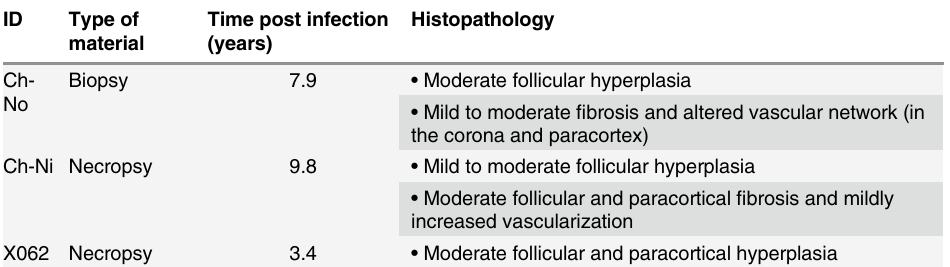
Findings of a veterinary pathologist (IK), upon analysis of H&E, Masson's Trichrome and anti-collagen-I stained slides of peripheral lymph